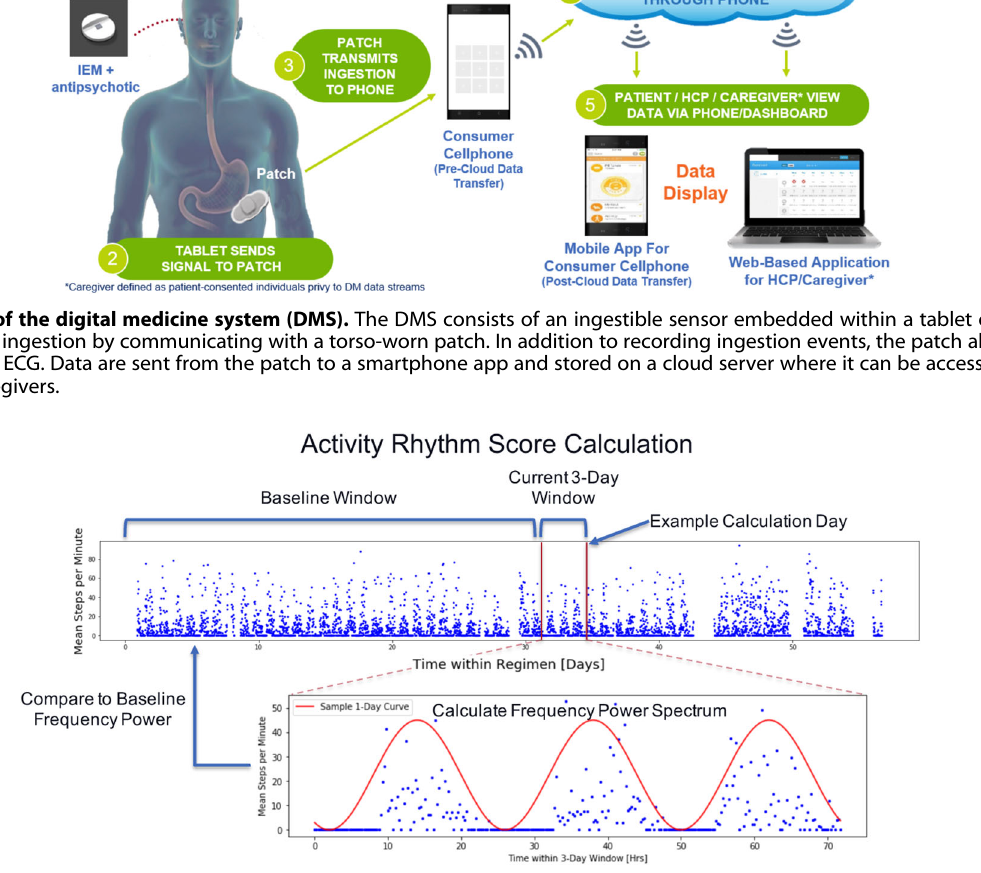
Fig. 2 Activity rhythm ( AR ) score calculation example. In order to calculate AR for a given day, the Lomb – Scargle periodogram is applied to a 3-day of window of step-count data leading up to and including that day, and a characteristic frequency f c is calculated for the time-series. AR is then de fi ned as the amplitude of that Lomb – Scargle periodogram at the mean of all characteristic frequencies from earlier days divided by the amplitude of the periodogram at f c . Thus, AR is a measure of how consistent the step count pattern is, relative to the pattern of earlier